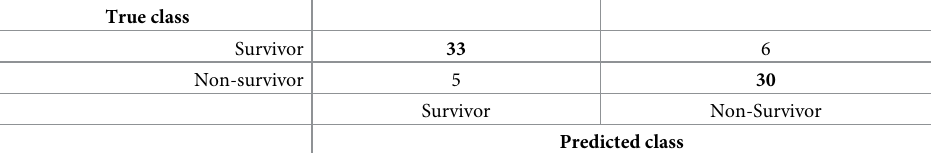
Table 2. Confusion matrix showing accuracy of Gradient Boosting Machine model when applied to test set of 74 mice. Using monitoring data collected at 18 and 24 HPC (weight, righting reflex and mobility), a Gradient Boosted machine learning model was able to distinguish survivors and non-survivors with an accuracy score of 0.85; 33/39 sur- vivors and 30/35 non-survivors were correctly